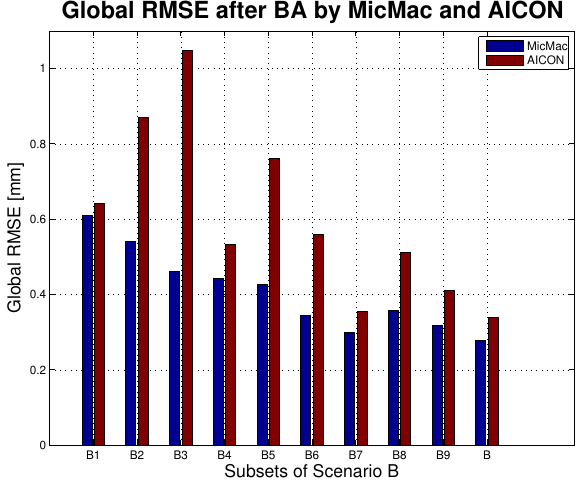
Figure 6: RMSE measured for subsets of Scenario B (described in Table 2), sorted by increasing number of images.